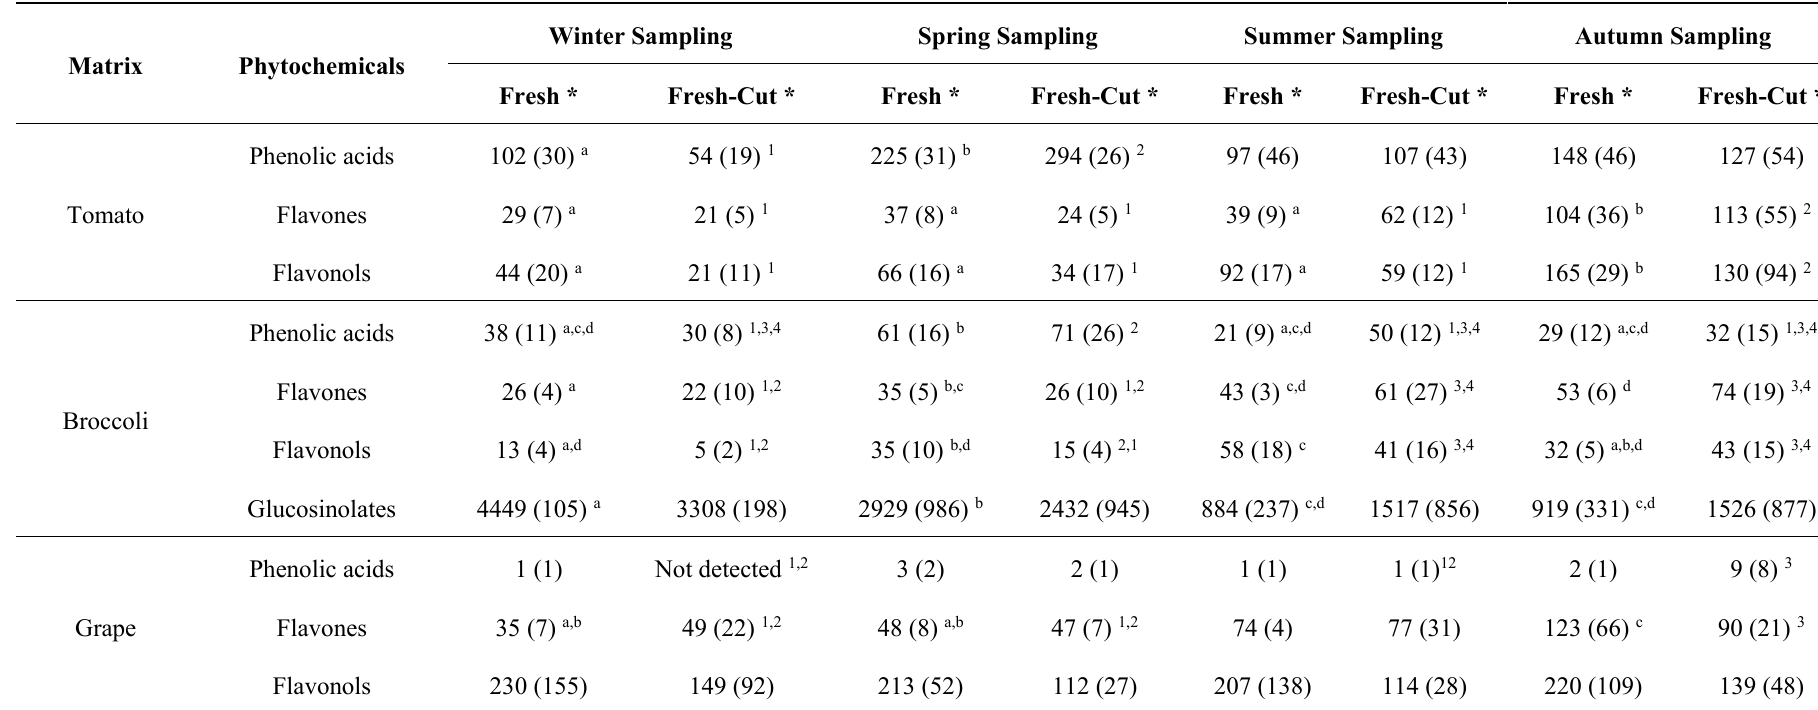
Table 1. Phytochemical content (expressed as mg/kg, dry weight (DW)) in fresh and fresh-cut in tomato, broccoli and grape in different seasons. Matrix